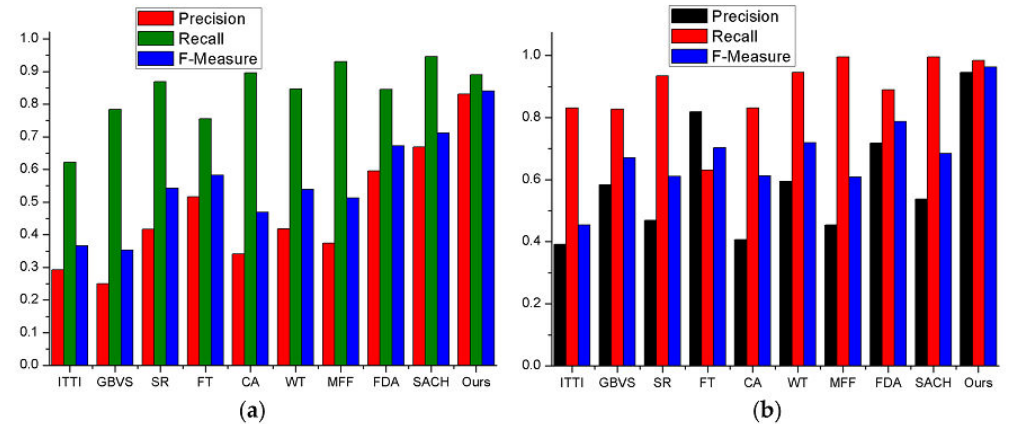
Figure 11. Precision, Recall and F-Measure of ROIs by our proposed model and nine competing models on ( a ) SPOT 5 and ( b ) Google Earth images.